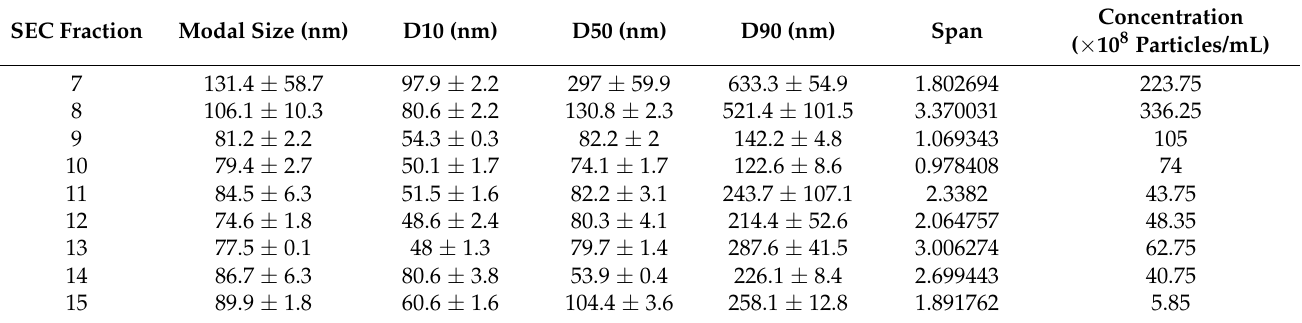
Table A1. Nanoparticle tracking analysis and protein concentration of size exclusion chromatography fractions. D10, D50, D90 = distribution up to which 10%, 50% and 90% of total volume of particles are contained, respectively. Span = (D90 − D10)/D50. SEC = size exclusion chromatography. Span = (D90 −